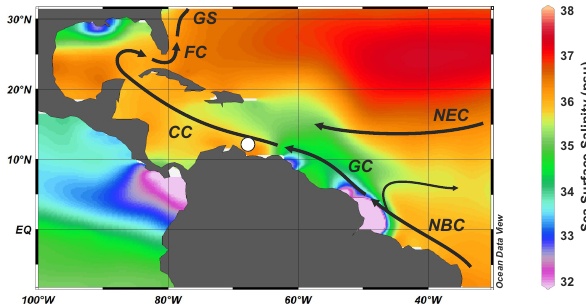
Fig. 1. Modern oceanographic setting of the Caribbean and west- ern North Atlantic. Schematic of major surface currents constitut- ing the upper branch of the Atlantic meridional overturning circula- tion (AMOC) are superimposed on annual mean sea surface salin- ity (Antonov et al., 2006). Major surface currents: North Brazil- ian Current (NBC), Guyana Current (GC), Caribbean Current (CC), Florida Current (FC), Gulf Stream (GS) and North Equatorial Cur- rent (NEC). White circle indicates the study site